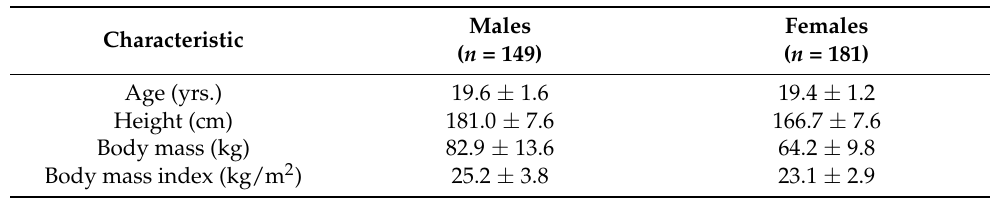
Table 1. Athlete